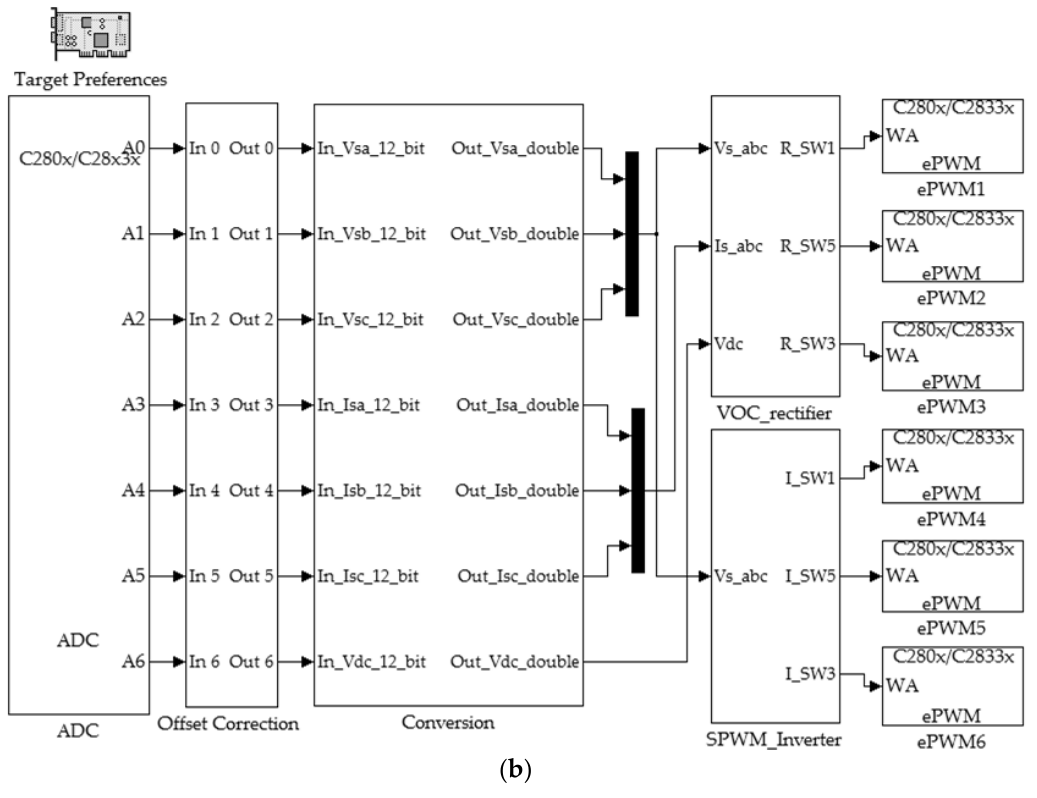
Figure 8. Simulation model of digital signal processor (DSP) implementation: ( a ) The control algorithm of PWM rectifier and ( b ) the control algorithm of the sinusoidal pulse-width modulation (SPWM) inverter.